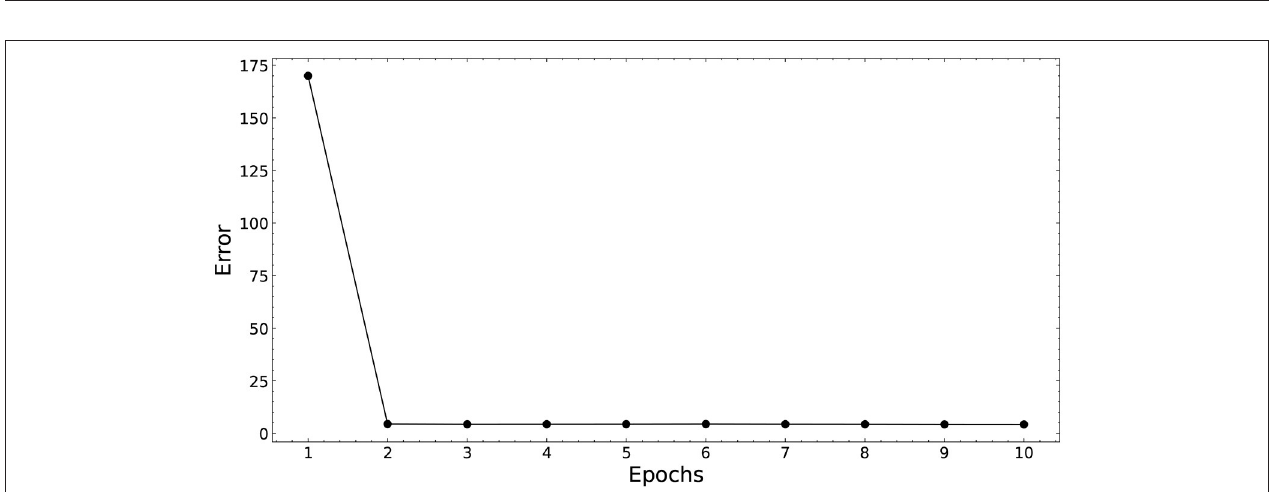
FIGURE 4 | A summary plot of the SHAP values for each feature. The vertical axis indicates the variable names, in the order of importance from top to bottom. The horizontal axis shows the mean absolute SHAP values. The motif occurrence rate contributed the most for predicting the change of LBP level.